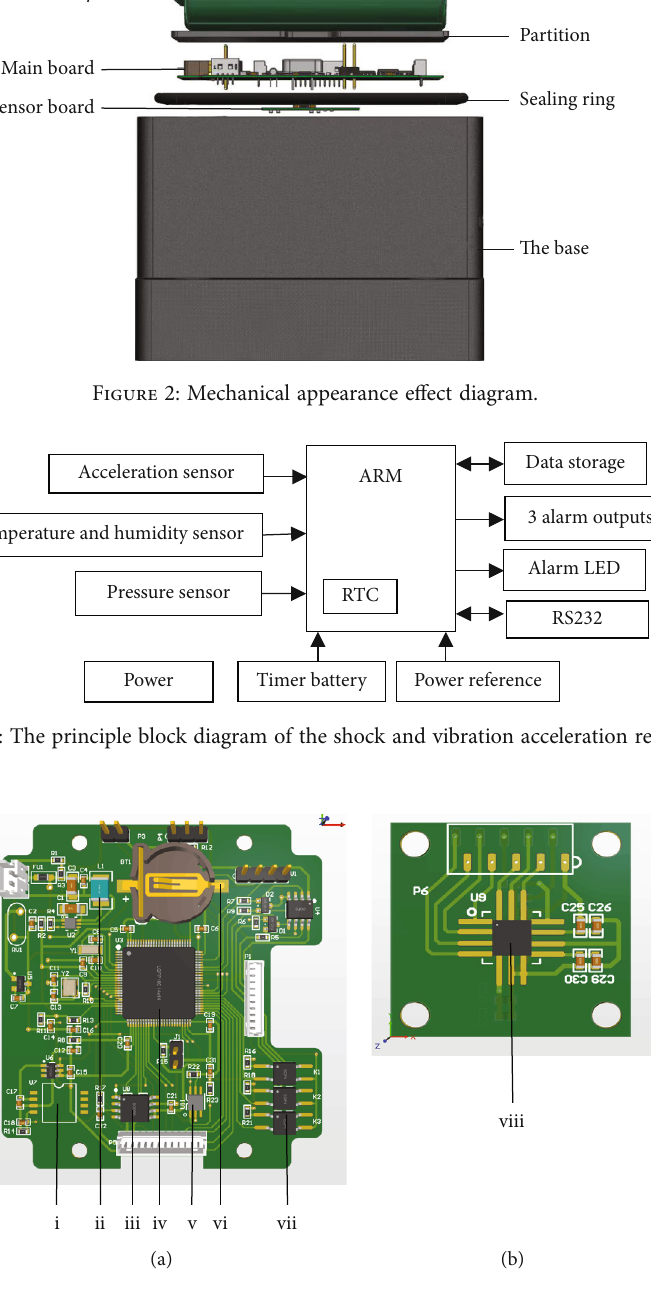
Figure 4: The PCB e ff ect diagram of the shock and vibration acceleration recorder. (a) Motherboard with (A) pressure measurement, (B) LDO power, (C) storage, (D) ARM, (E) humidity and temperature measurement, (F) timer battery, and (G) alarm output. (b) Sensor board with (A) acceleration MEMS